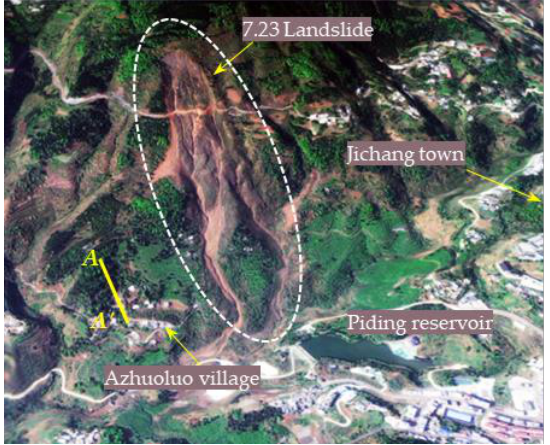
Figure 8. Topography of the study area.